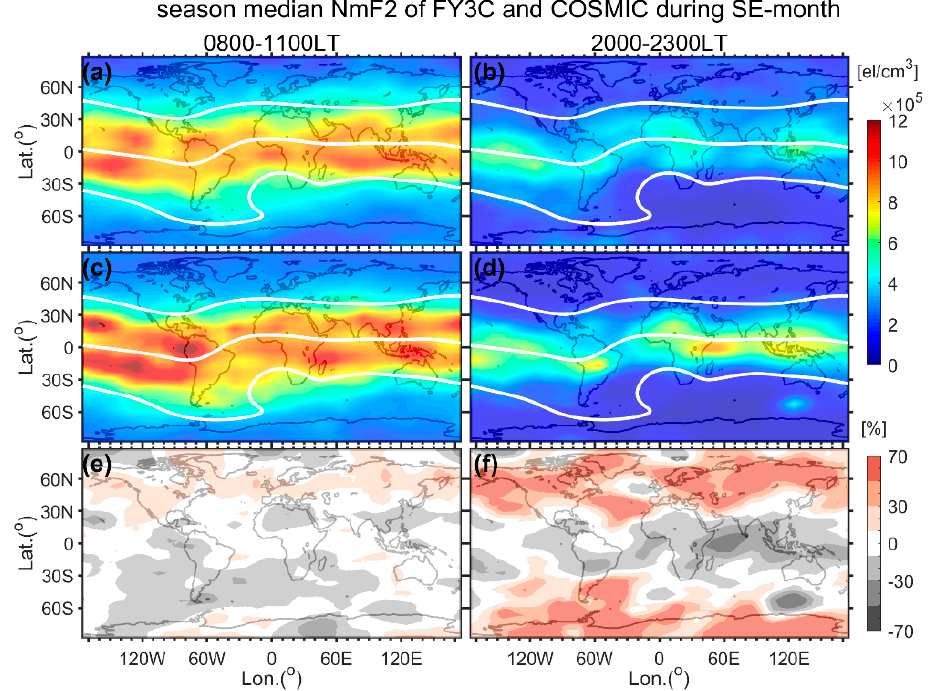
Figure 8. Ionospheric climatological characteristics of season median NmF2 observed by FY3C/GNOS and COSMIC and their differences at 0800–1100LT and 2000–2300LT during SE-month (±45 days to September equinox of 2016) from 2016.221 to 2016.311. Refer to Figure 6 for more detailed explanations.